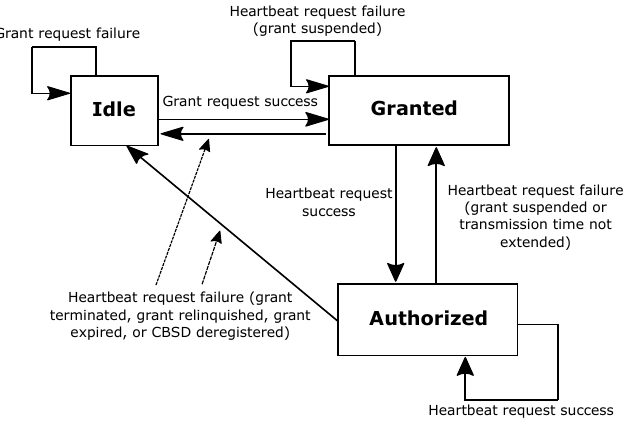
Figure 4. CBSD grant state diagram.